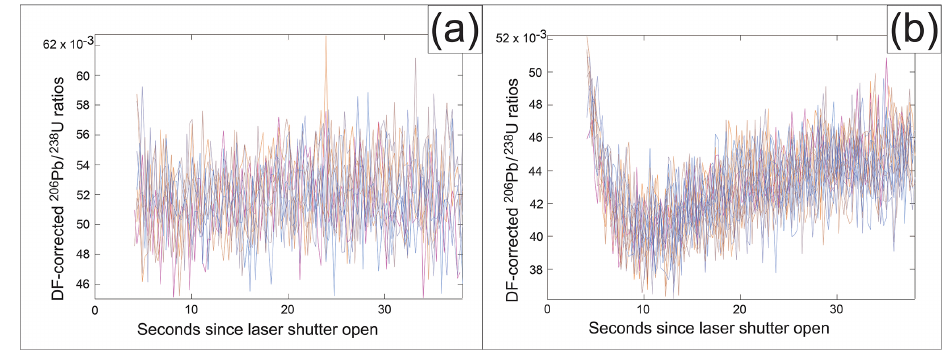
Figure 4. 206 Pb / 238 U ratios measured by LA-ICP-MS corrected for downhole fractionation (DF) of (a) CAP b allanite and (b) Plešovice zircon with Tara allanite as the primary reference material. Each individual line represents one analysis. Measurements are with a 50µm spot size. The DF-corrected 206 Pb / 238 U ratios include both initial and radiogenic Pb.